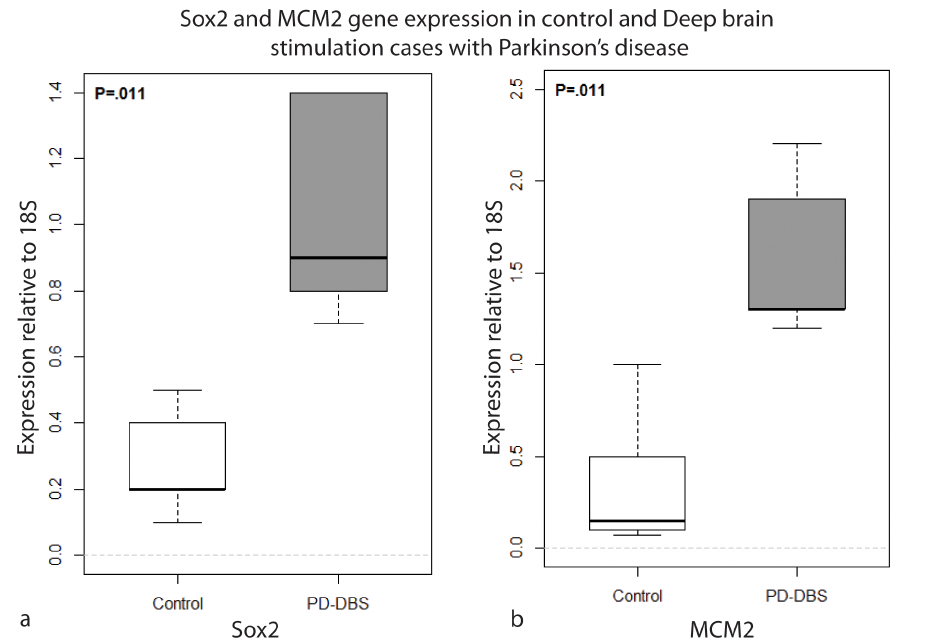
Figure 3. Sox2 and MCM2 gene expression is increased in the lining of the third ventricle and per-lead region in PD-DBS brains. Boxplots of gene expression relative to 18S for Sox2: control and PD-DBS groups. The permutation test p-value shows that the expression level is significantly higher in the PD-DBS group at the 0.05 level. Boxplots of expression relative to 18S for MCM2: control and PD-DBS groups. The permutation test p-value shows that the expression level is significantly higher in the PD-DBS group at the 0.05 level. The relative gene expression level was normalized on the basis of the expression of a reference gene (18S) and was also normalized on the basis of the expression of a reference sample (calibrator). Final results are expressed in arbitrary units in gene expression relative to the expression of 18S gene and calibrator sample. The relative expression was calculated by 2 2 DD CT , where CT=fluorescence threshold value; D CT=CT of the target gene – CT of the reference gene (18S) ; DD CT= D CT of the treated sample – D CT of the reference sample. A pool of five normal tissue samples served as the reference sample. The increased levels of gene expression of Sox2 and MCM2 correlate with the immunolabelling and cell count data.